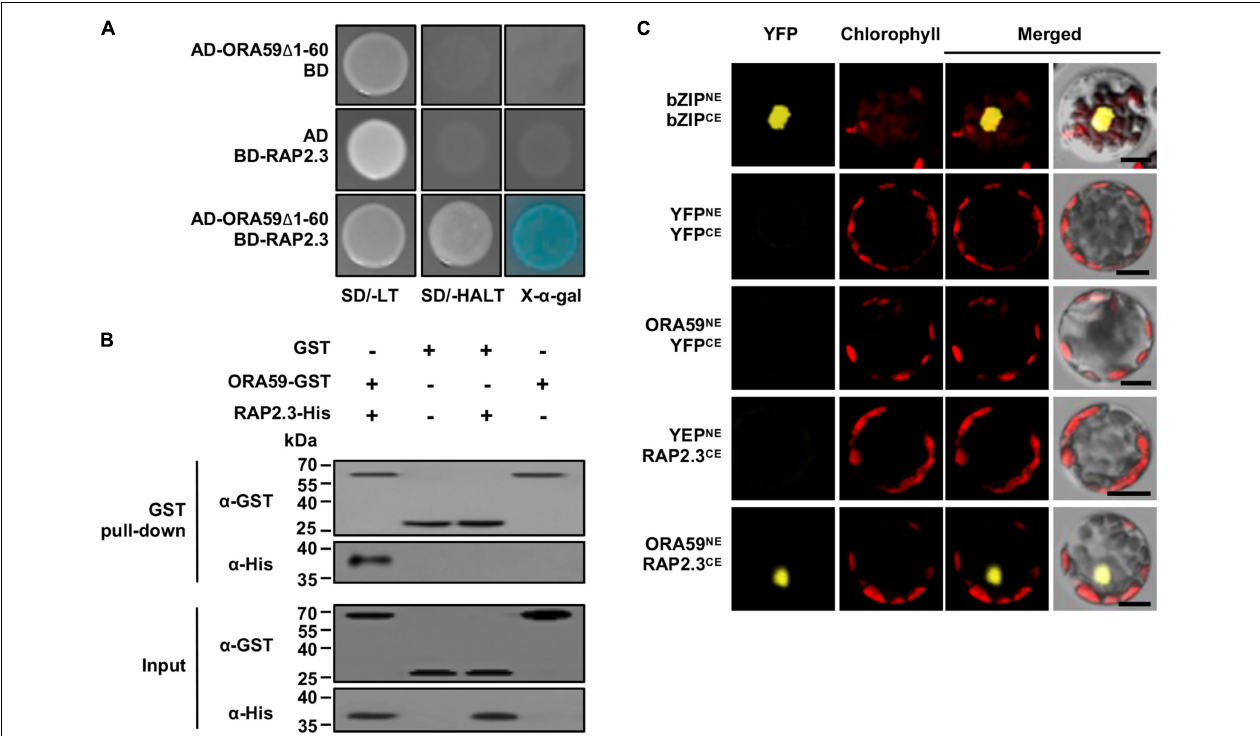
FIGURE 1 | Physical interaction of ORA59 with RAP2.3. (A) Yeast two-hybrid assay. ORA59 with N-terminal 60 amino acids deleted (ORA59 (cid:49) 1-60) and full-length RAP2.3 were fused with GAL4 AD and BD, respectively. Their interactions were tested on selective media SD/-AHLT and in the presence of X- α -Gal. (B) In vitro GST pull-down assay. GST or ORA59-GST was incubated with RAP2.3-His and precipitated with glutathione sepharose 4B beads. Proteins were detected by immunoblotting with anti-GST and anti-His antibodies. Input shows 1% of the amount used in binding reactions. WB, western blotting. (C) BiFC assay. YFP NE , YFP CE , and their fusion proteins bZIP63 NE , bZIP63 CE , ORA59 NE , and RAP2.3 CE were expressed in Arabidopsis protoplasts as indicated. YFP fluorescence signals were visualized under a confocal microscope. Bars, 10 µ m. Experiments were repeated three times with similar